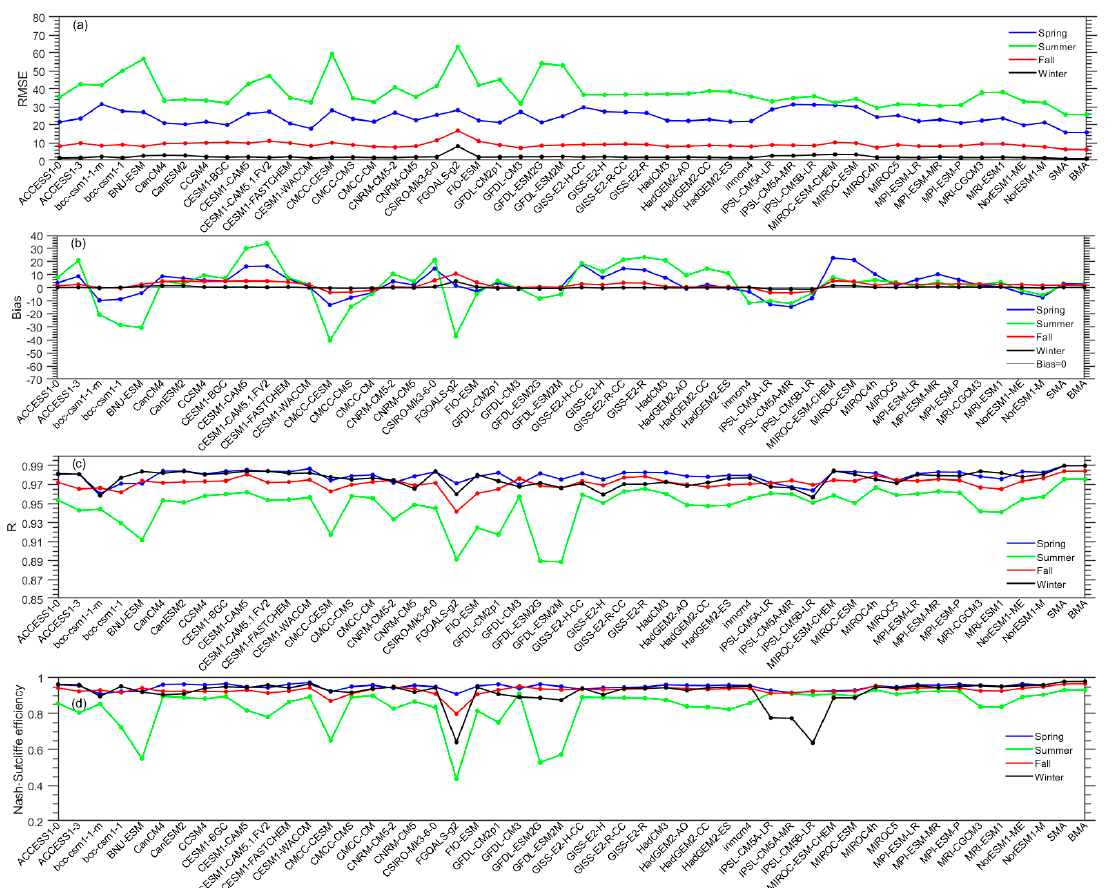
Figure 11. Seasonal statistical results of the SSR simulations from 48 GCMs in CMIP5 with the CERES EBAF retrievals from 2000 to 2005 in the Southern Hemisphere. ( a ) RMSE, ( b ) Bias, ( c ) R, ( d ) NSE (in units of W m − 2 ).